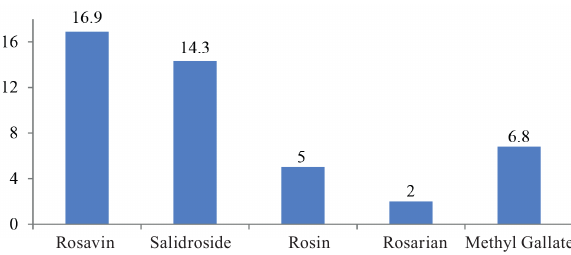
Figure 4 Content of biologically active substances in Scutellaria galericulata L., mg/g